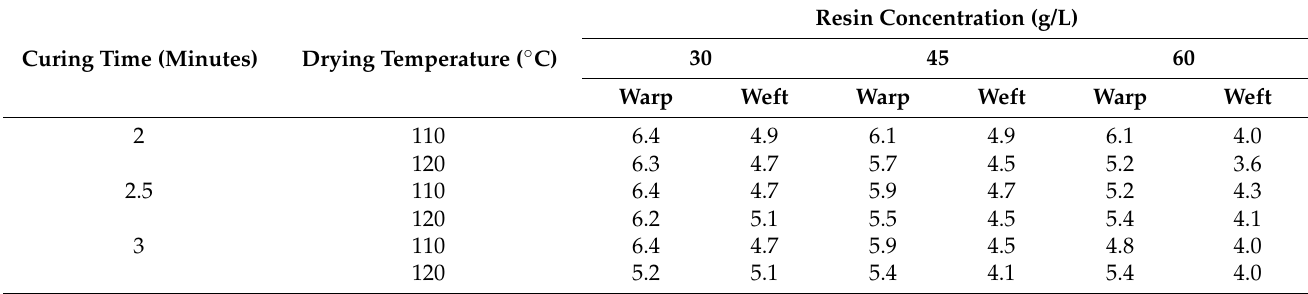
Table 7. Relationship between resin concentration and tearing